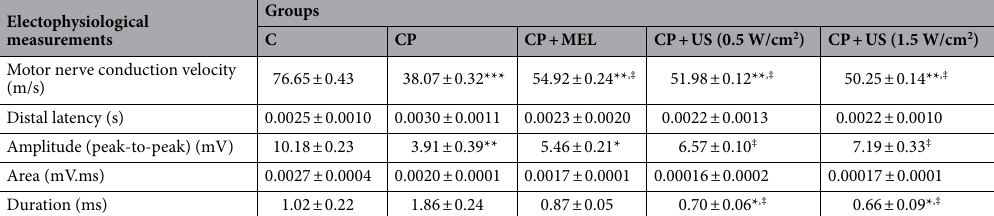
Table 3. The results of the alterations in distal latency, peak-to-peak amplitude, area and duration of the compound muscle action potential recordings, and the sciatic motor nerve conduction velocities in the experimental study groups. The data were represented as mean ± standard error of mean. Differences in between variances were compared by One-way ANOVA test with Tukey’s test applied as a post-hoc test. P -values equal or less than 0.05 were considered as statistically significant (* p < 0.05, ** p < 0.01, *** p < 0.001). The degree of significance was symbolized by an asterisks (*) for the comparison of all groups with respect to the control group; by a double daggers (‡) for the comparison of the treatment groups with respect to the cisplatin administered group; by a daggers (†) for the comparison of ultrasound treated groups with respect to the melatonin administered group and by a section (§) for the comparison of 1 MHz 1.5 W/cm 2 US treated group with respect to the 1 MHz 0.5 W/cm 2 US treated